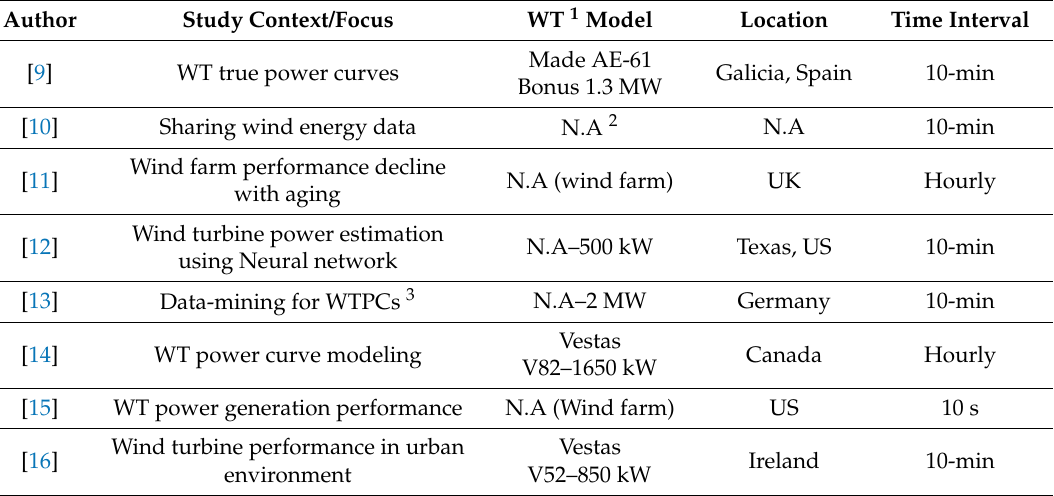
Table 1. Literature with evidence of dispersion of actual power curve from the theoretical power